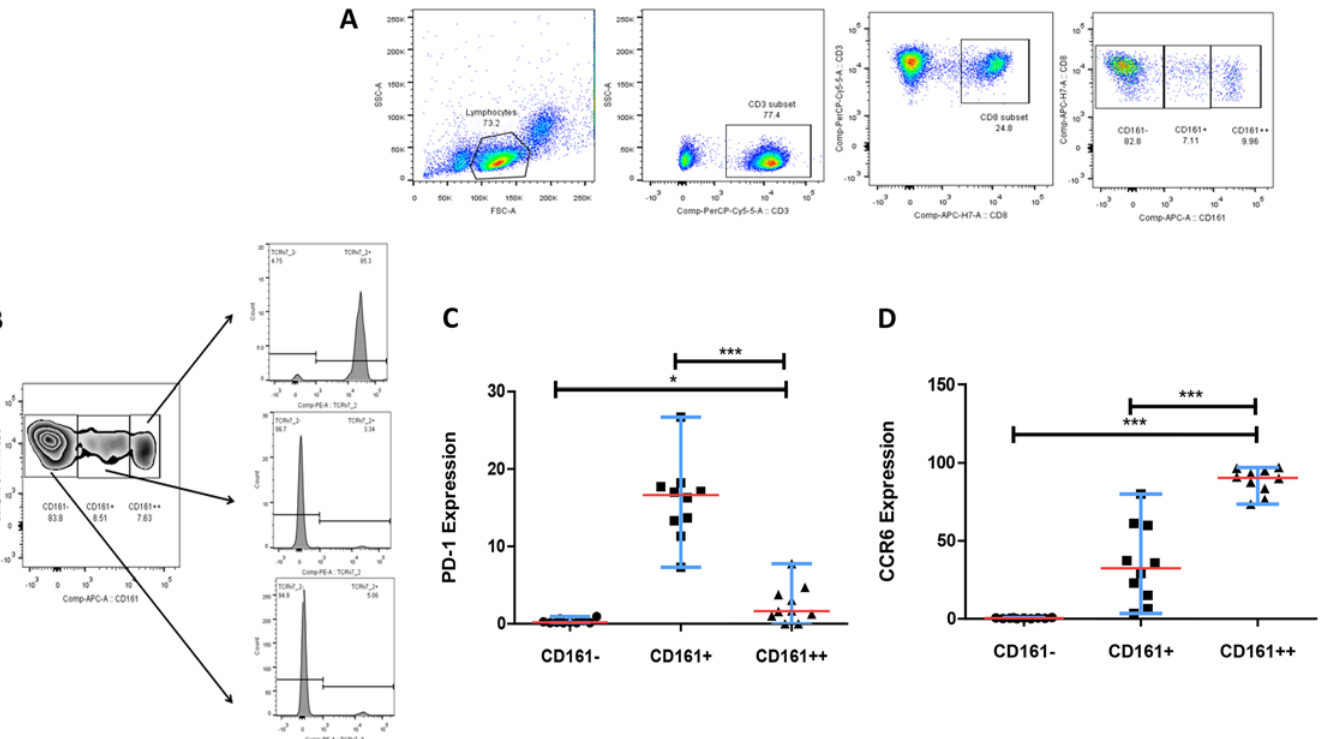
Fig 1. Phenotypic properties of CD161 ++ CD8 + T-cells. (A) Depiction of the gating strategy used: During acquisition, lymphocytes were selected on the basis of forward-scatter and side-scatter characteristics. MAIT cell subsets were gated from CD3, CD8 and CD161 bright cells, viz., CD3 + CD8 + CD161 ++ defined as MAIT cells. ( B) Histograms (gated on the CD8 + T-cell population) show differential expression of TCR V α 7.2 by CD161 ++ , CD161 + and CD161 - CD8 + T cells from a representative sample from healthy controls (HC). (C) Collective data from 10 HCs demonstrated differential expression of PD-1 by CD161 ++ , CD161 + and CD161 - CD8+ T cells. (D) Aggregate data from 10 HCs demonstrated differential expression of CCR6 by CD161 ++ , CD161 + and CD161 - CD8 + T-cell subsets. All graphs show median (red bars) and range (blue whiskers); P values are reported for two-sided Mann-Whitney tests with threshold for significance P = 0.02 after Bonferroni correction for 2